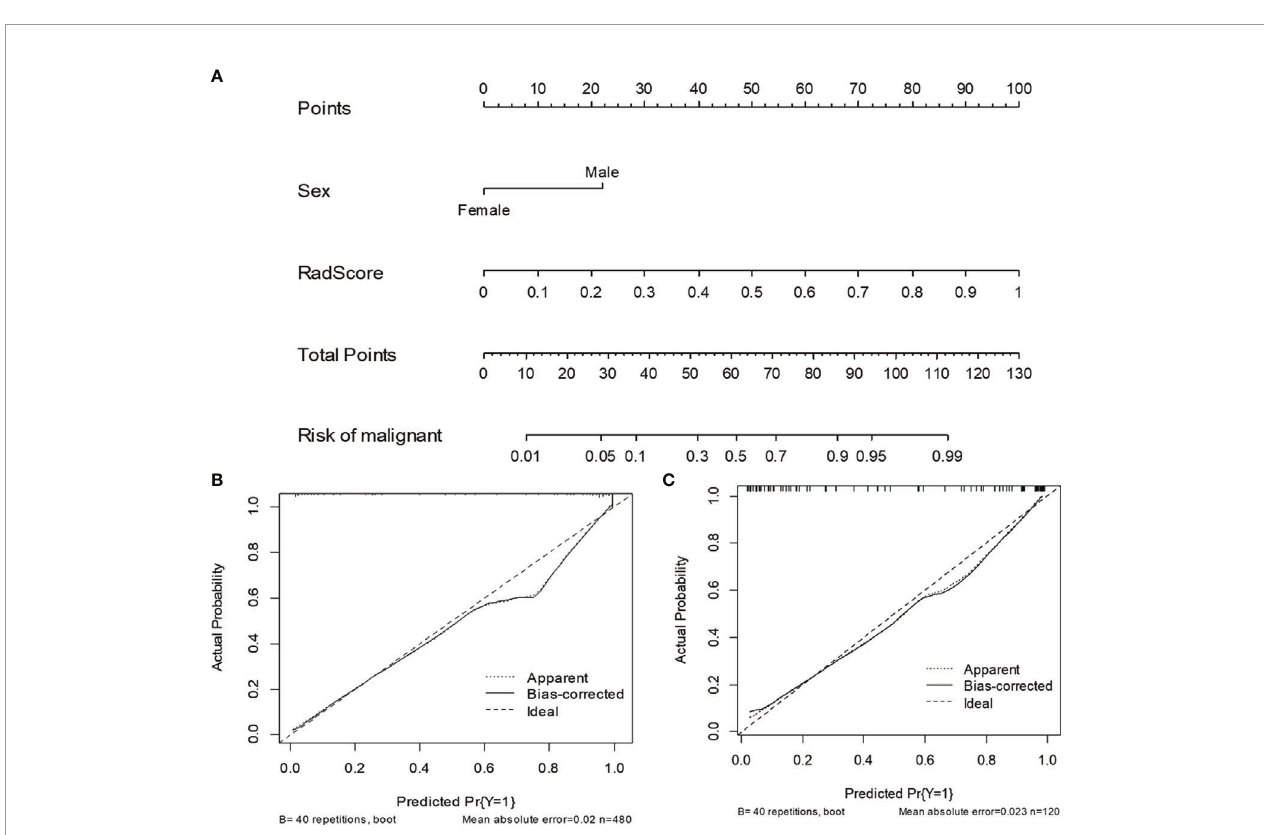
FIGURE 4 | The radiomics nomogram and calibration curves for the radiomics nomogram. The radiomics nomogram, combining sex and RadScore, developed in the training set (A) . Calibration curves for the radiomics nomogram in the training (B) and validation (C)